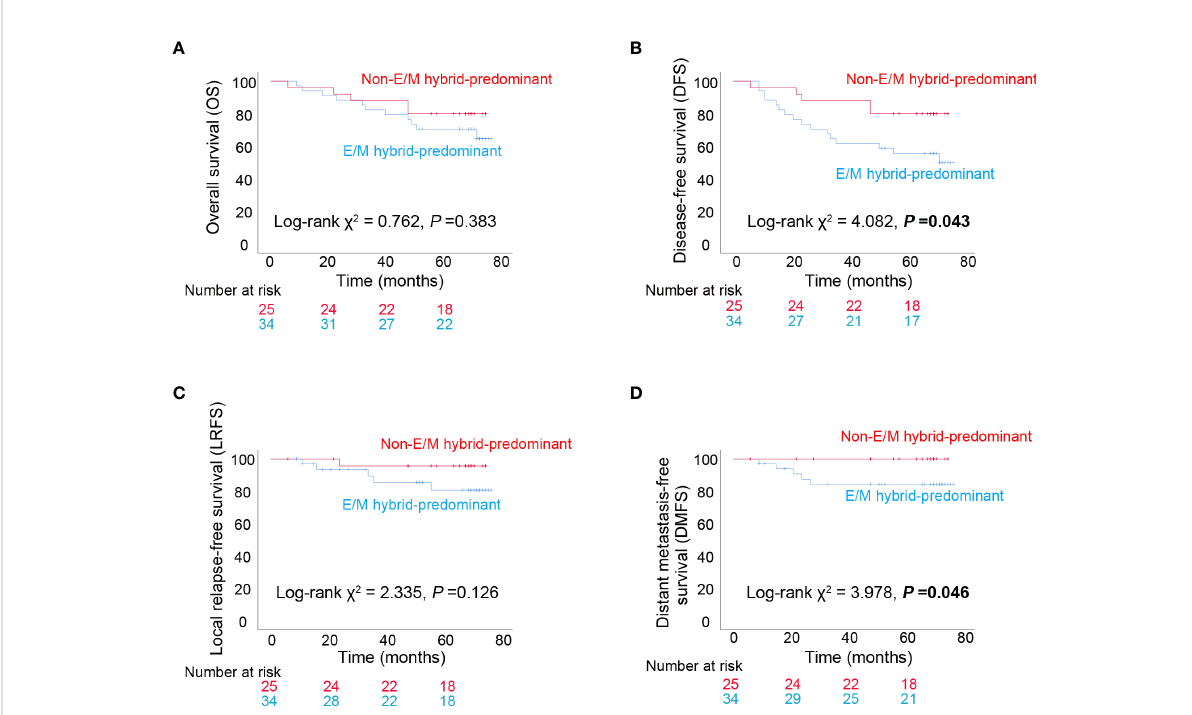
FIGURE 5 Long-term clinical outcomes among patients with progressive nasopharyngeal carcinoma. (A) Kaplan – Meier analysis of overall survival (OS) among patients with epithelial/mesenchymal (E/M) hybrid-predominant or non-E/M hybrid-predominant distribution of circulating tumor cells (CTCs). (B) Kaplan – Meier analysis of disease-free survival (DFS). (C) Kaplan – Meier analysis of local relapse-free survival (LRFS). (D) Kaplan – Meier analysis of distant metastasis-free survival (DMFS). The log-rank test was performed for between-group comparisons of survival